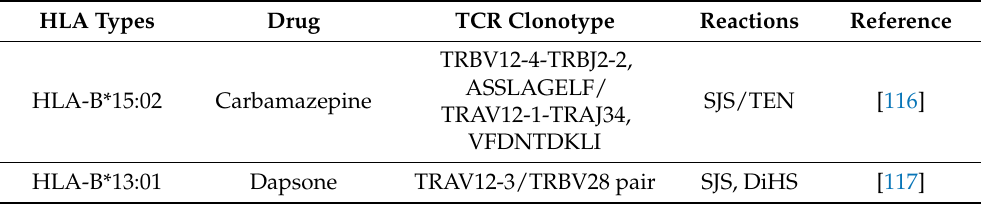
Table 7. TCR clonotype usage in